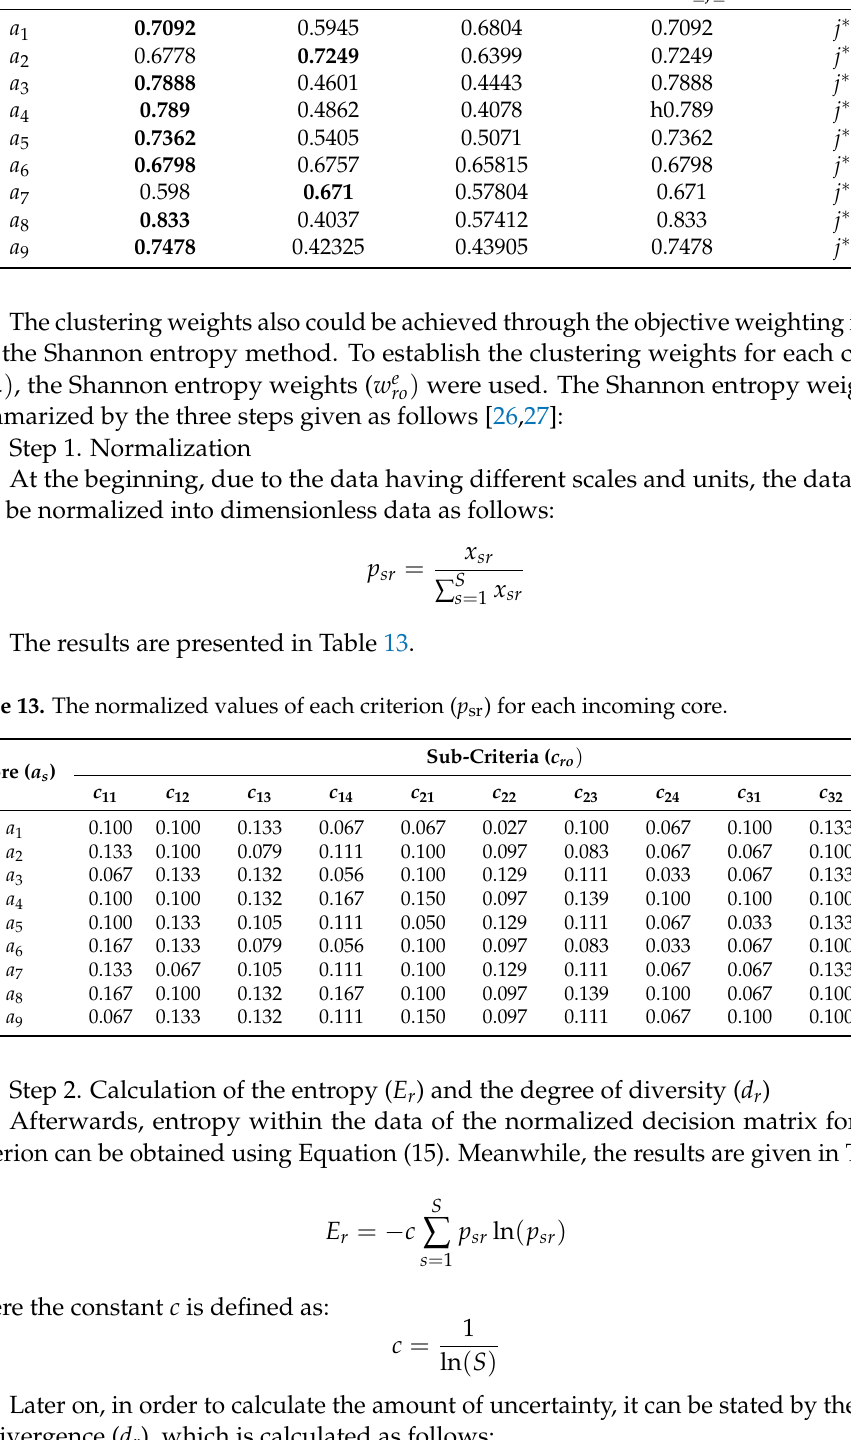
(cid:16) (cid:17) σ j s with subjective